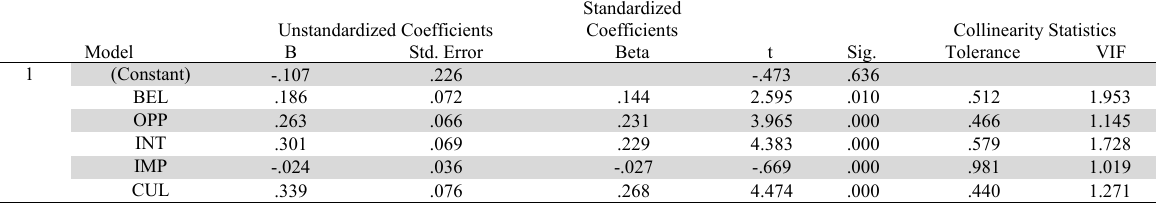
The result of the partial correlative appraisal of regression coefficient Model